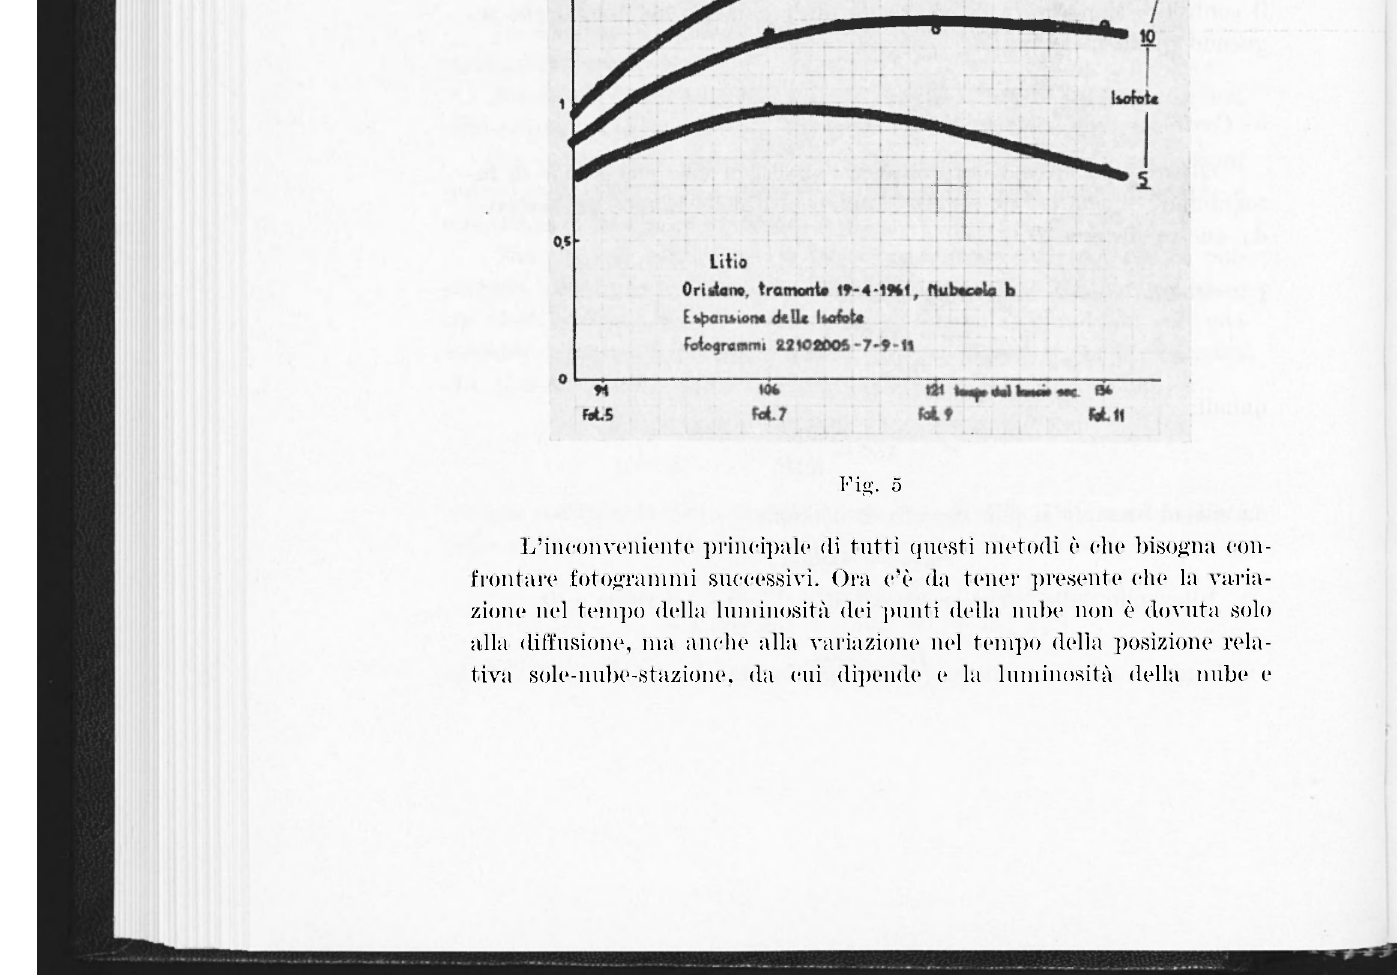
frontare fotogrammi successivi. Ora c'è da tener presente che la varia- zione nel tempo della luminosità dei punti della nube non è dovuta solo alla diffusione, ma anche alla variazione nel tempo della posizione rela- tiva sole-nube-stazione, da cui dipende e la luminosità della nube